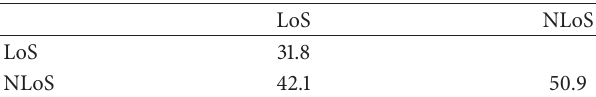
Table 7: Average distance between WINNER LoS and NLoS propagation conditions.